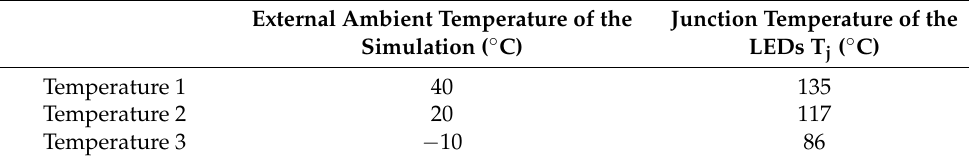
Table 9. Junction temperatures of the LEDs obtained in the simulations (T j ). Source: our own